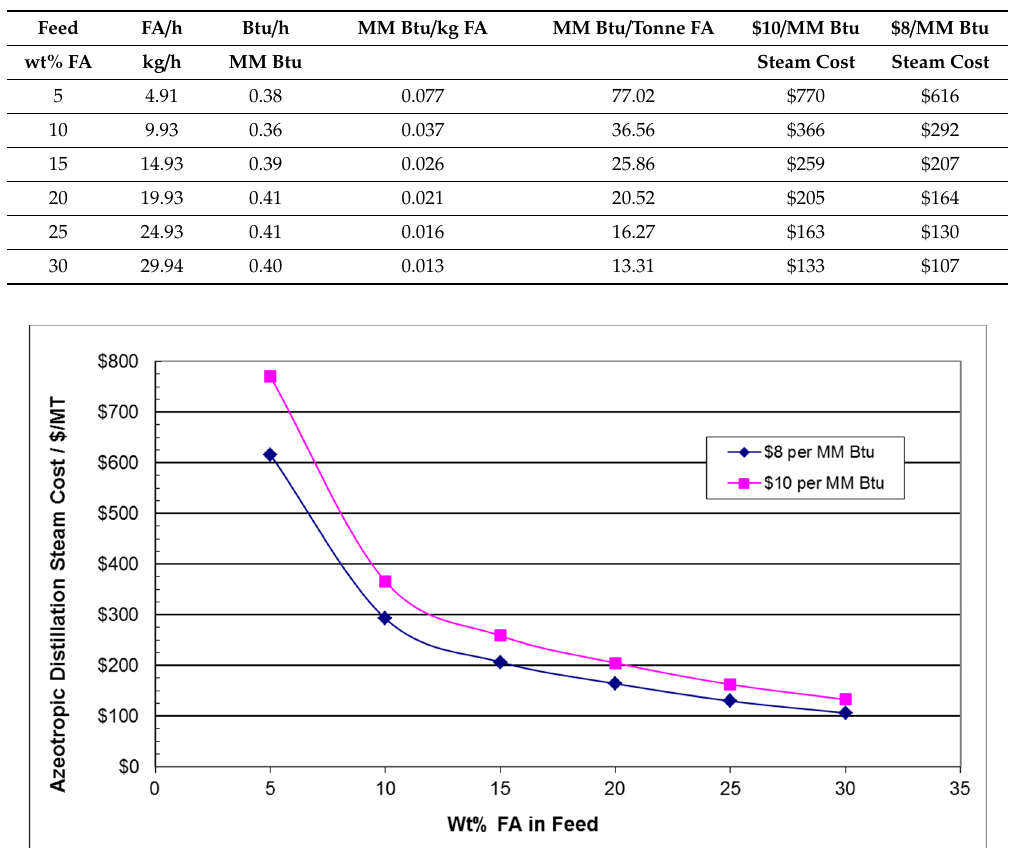
Figure 7. Formic acid estimated steam cost per metric ton FA versus the input wt% FA feed concentration for a pressurized azeotropic distillation column at steam costs of $8 and $10 per MM Btu (1.055 MM kJ)